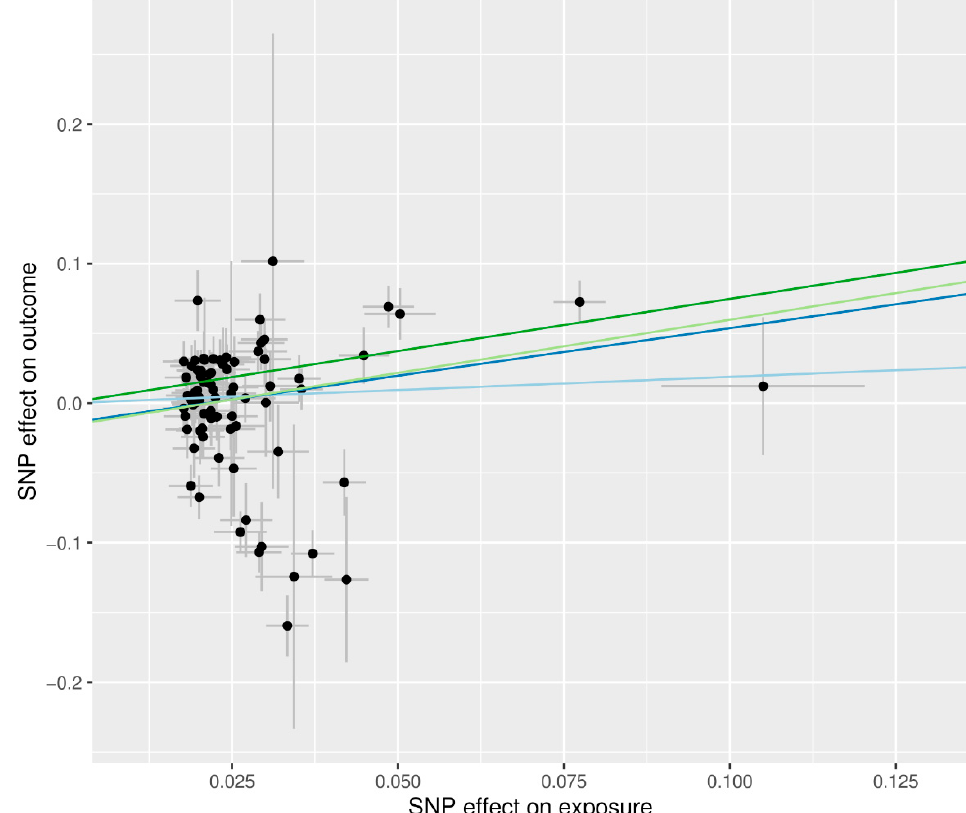
Figure 3. Scatter plots of MR tests assessing the effect of BMI on T2D. The dots represent the effect size ( β ) of each SNP on BMI ( x -axis) and T2D ( y -axis), and the grey lines show their standard errors. Regression slopes show the estimated causal effect of BMI on T2D. The light blue, dark blue, light green, and dark green regression lines represent the IVW, MR-Egger, MR-Egger (SIMEX), and weighted median estimate, respectively. MR: Mendelian randomization; BMI: body mass index; T2D: type 2 diabetes; SNP: single nucleotide polymorphism; IVW: inverse-variance weight; SIMEX: simulation extrapolation.